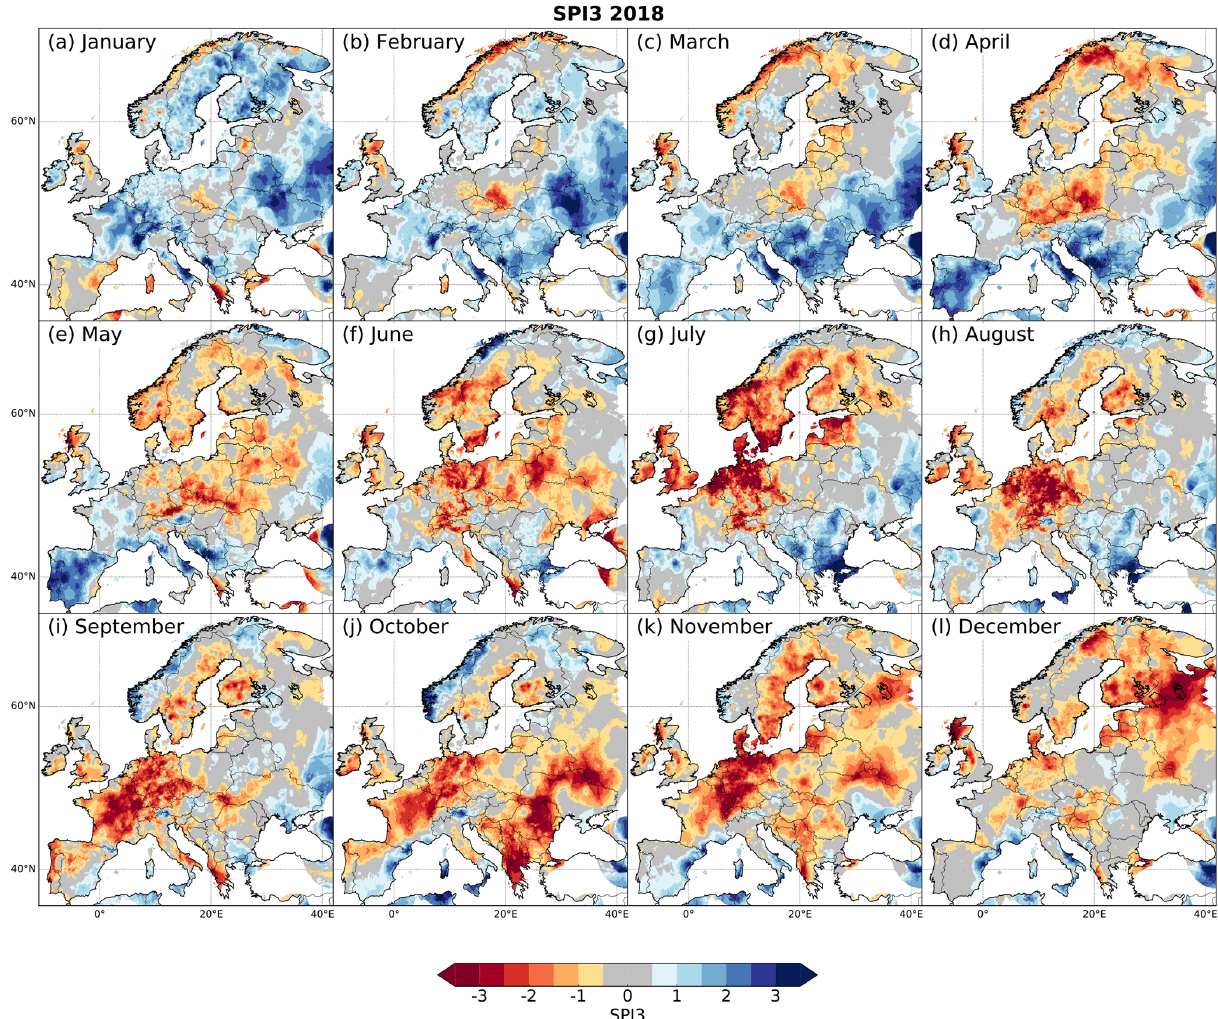
Figure A6. Monthly meteorological drought indexed by SPI3 throughout 2018 relative to the reference period